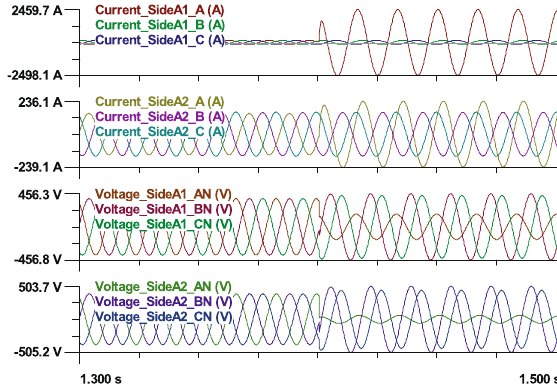
Fig. 4 Three phase currents and voltages of event 1: internal bolted fault, grid-connected mode